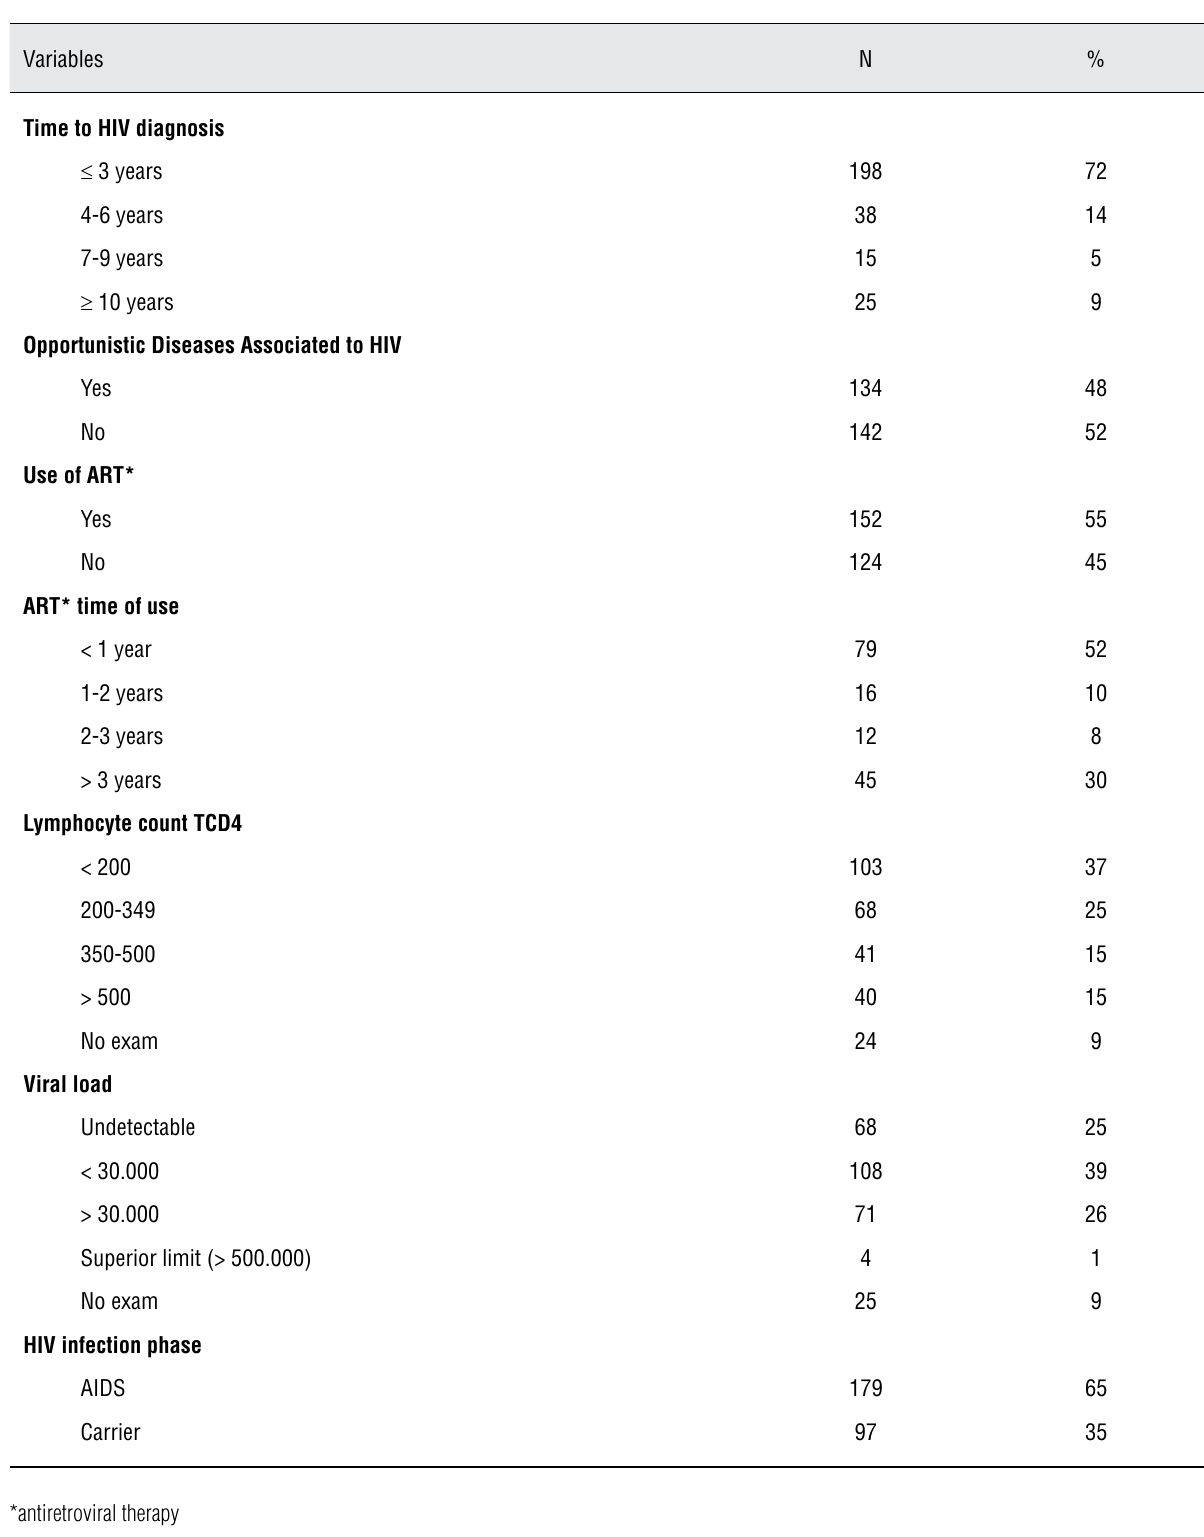
Table 3 - Variables associated to the presence of HIV